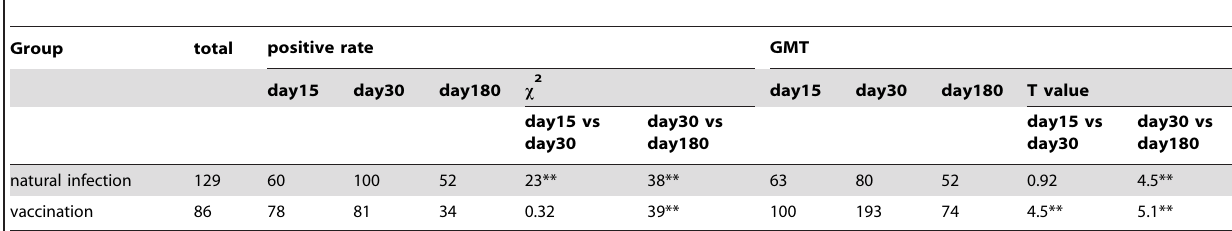
Table 1. Positive rate and GMT of 2009 H1N1 virus antibody in a follow-up study of natural infection patients and vaccinated people, Guangzhou,